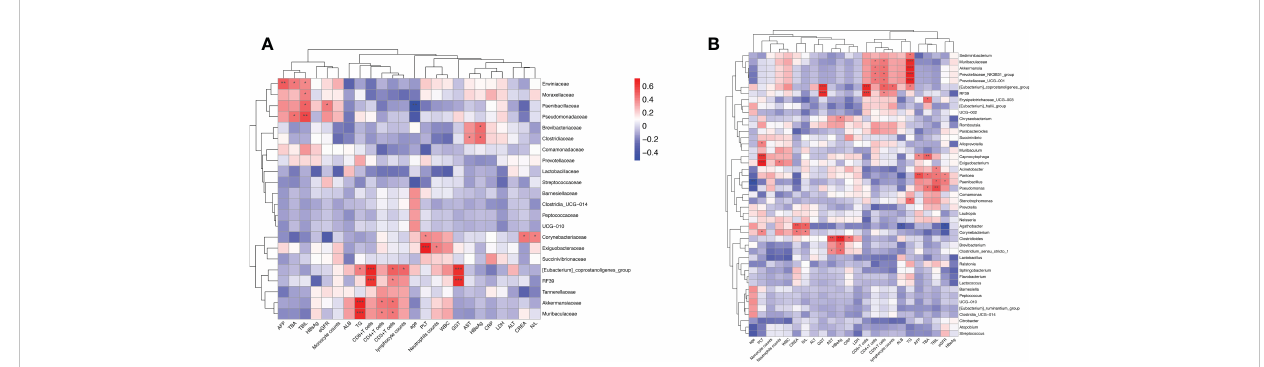
FIGURE 8 The intestinal microbiome of HBV-HCC patients at the family level is correlated with clinical liver function, lipid metabolism, and immune cell count. Heatmap of the correlation analysis between predominant bacterial families (A) and genera (B) and the clinical biochemical parameters of patients with HBV-HCC. Red color indicates a positive correlation while blue color indicates a negative correlation; *p<0.05; **p<0.01;